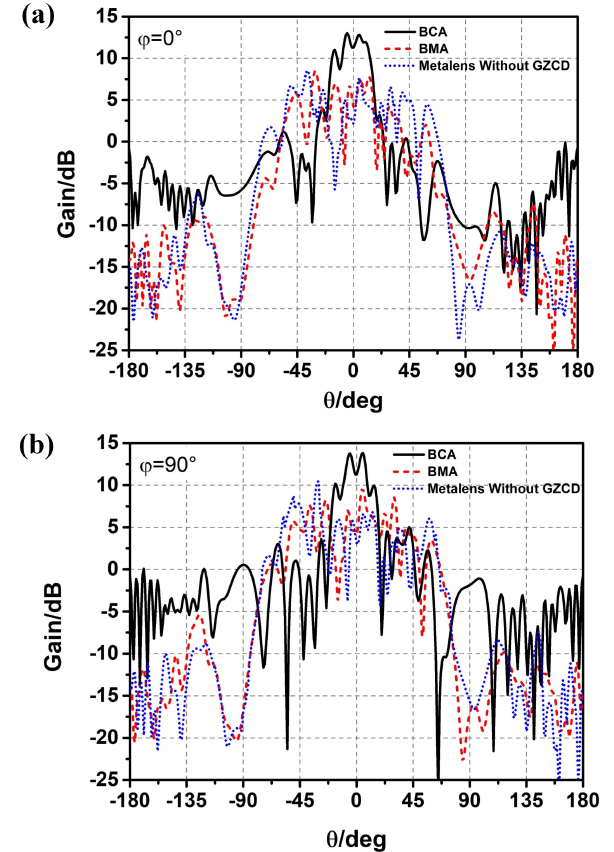
Figure 4. Comparison of radiation patterns of the BCA covered by a metalens without gradient zoom coefficient design (GZCD), the BCA, and the BMA; ( a ) ϕ = 0 ◦ ; ( b ) ϕ = 90 ◦